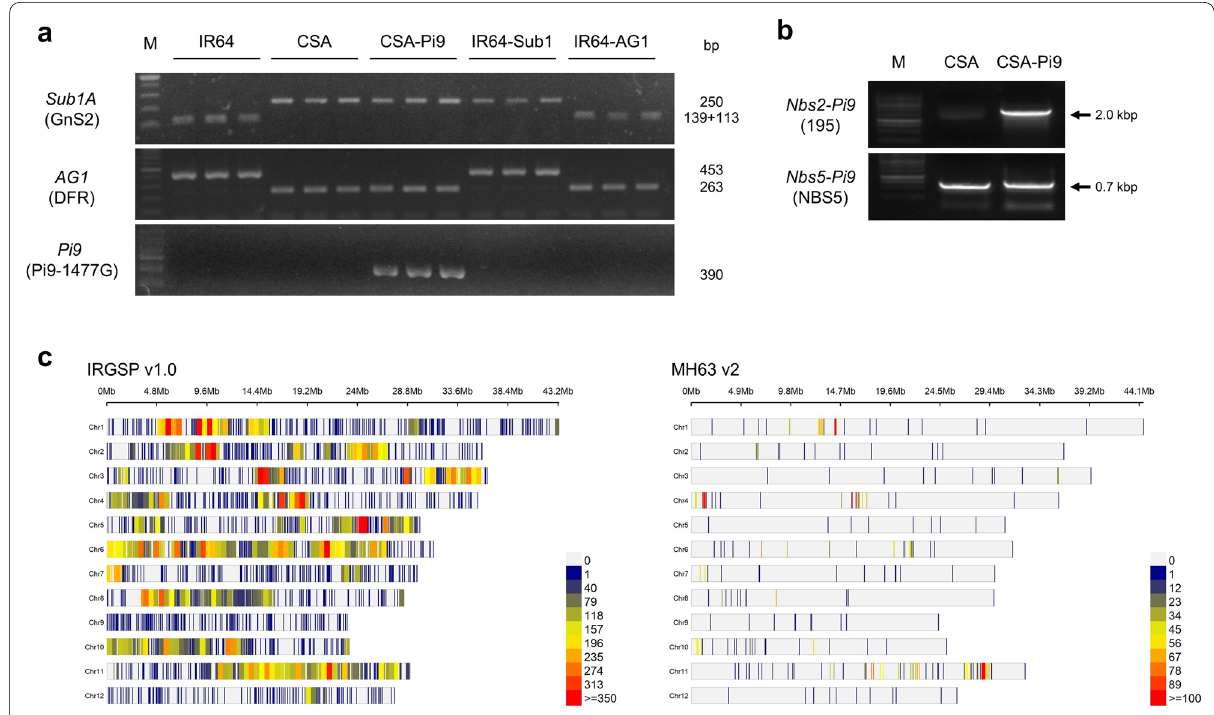
Fig. 2 Analysis of the genetic background and foreground selection of CSA‑Pi9. Foreground selection of CSA‑Pi9 using Sub1A- , AG1- and Pi9- specific markers ( a , b ). Analysis of the genetic background of CSA‑Pi9 using the KNU Axiom Oryza 580 K Genotyping Array containing SNPs designed on the basis of IRGSPv1.0 (left) and MH63 v.2 (right) ( c ). M: marker; bp: base pair; kbp: kilobase pair